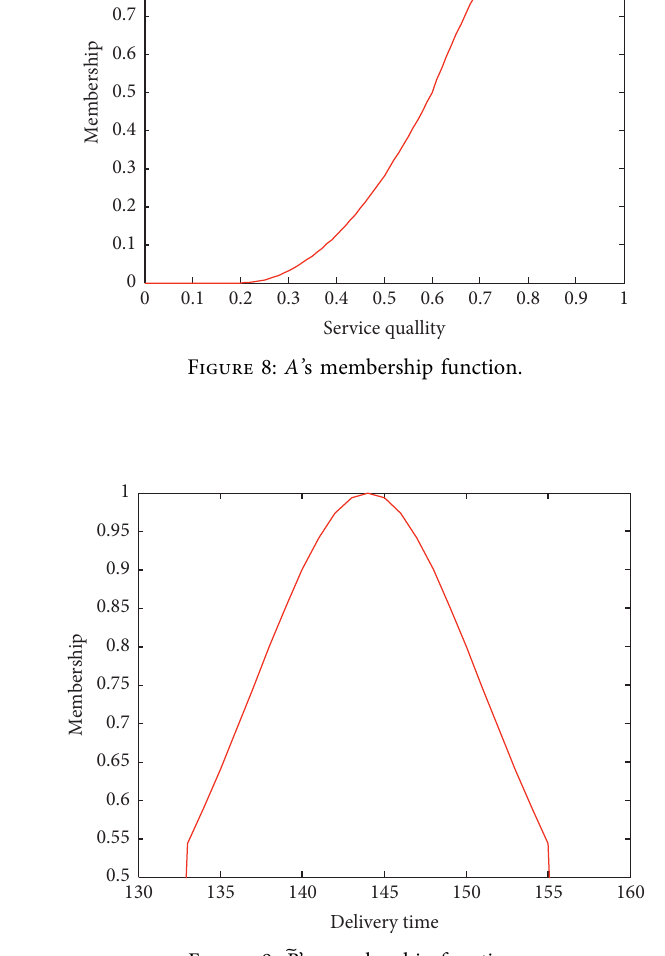
Table 9: The membership of 􏽥 M